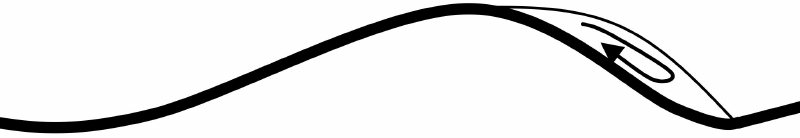
Figure 1. Schematization of a dune (flow left to